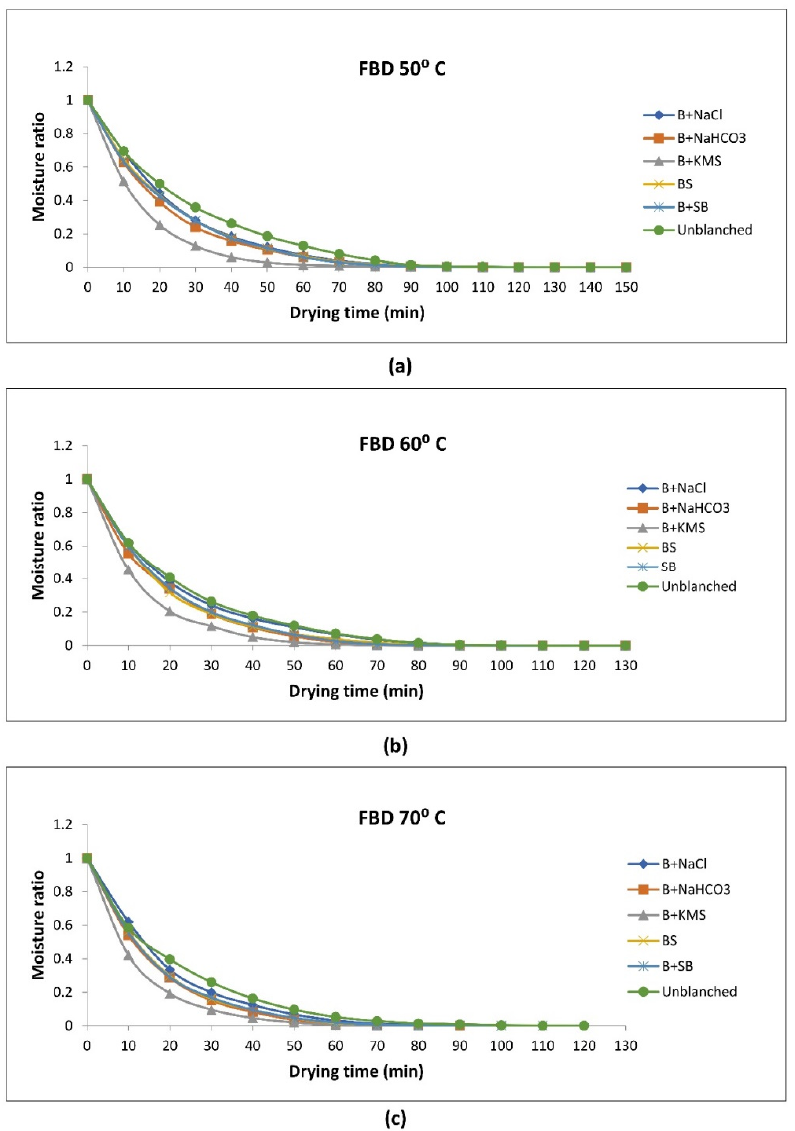
Figure 1. ( a – c ): Moisture ratio versus drying time curves as influenced by pretreatments under fluidized bed drying (FBD) at 50 °C ( a ), 60 °C ( b ), and 70 °C ( c ). fluidized bed drying (FBD) at 50 ◦ C ( a ), 60 ◦ C ( b ), and 70 ◦ C ( c